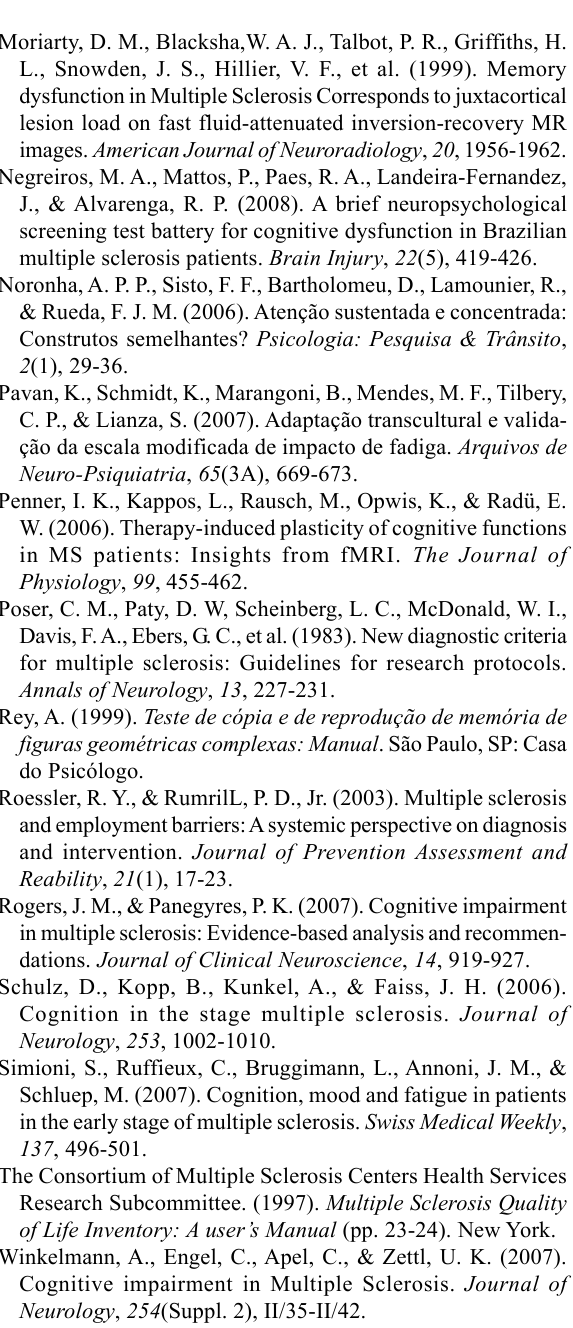
figuras geométricas complexas: Manual . São Paulo, SP: Casa do